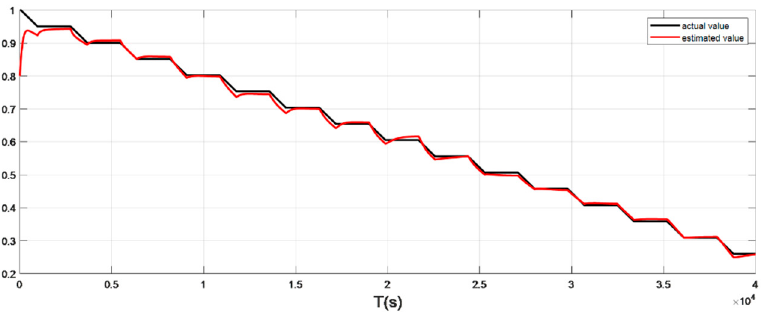
Figure 8. Comparison of the SOC real value and estimated value under constant current discharge (low temperature: 0 °C).